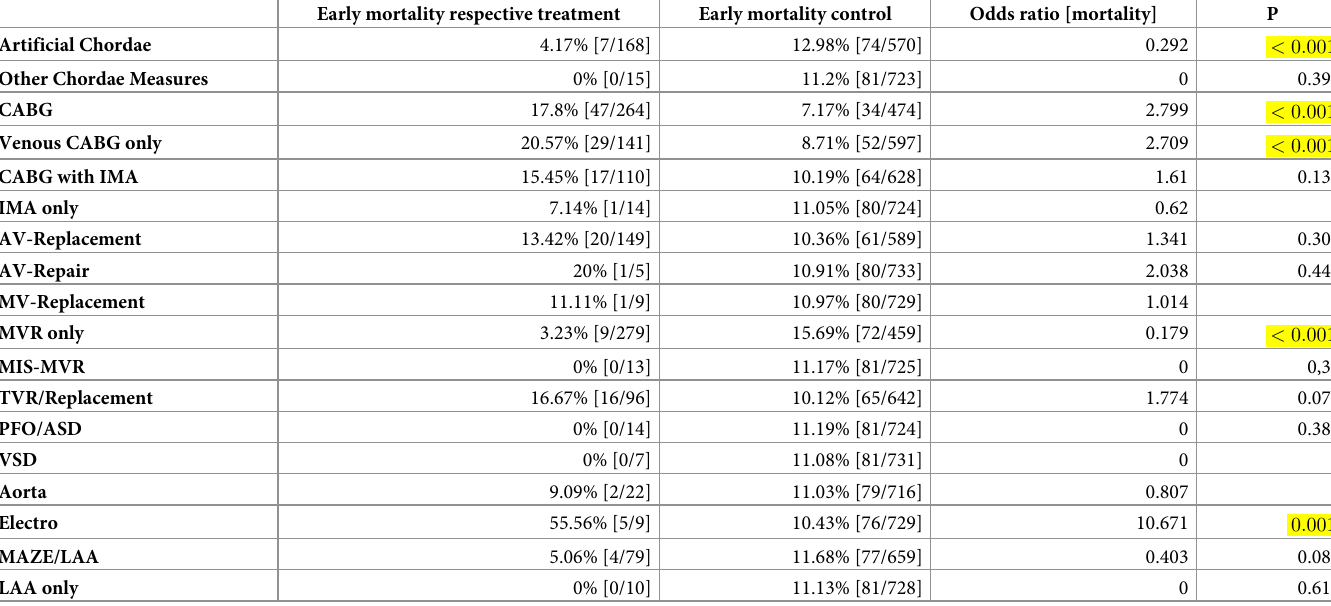
Table 4. Procedure-dependent early